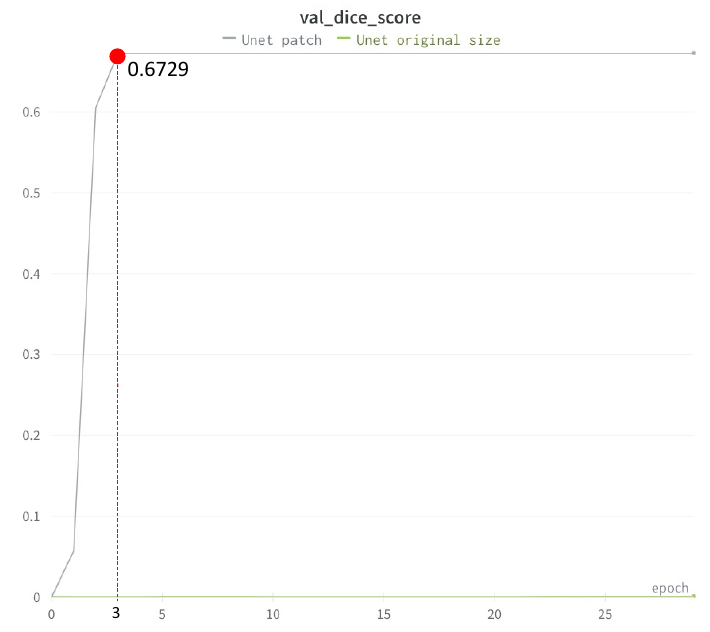
Figure 17. Training log (patch-split and original size input).